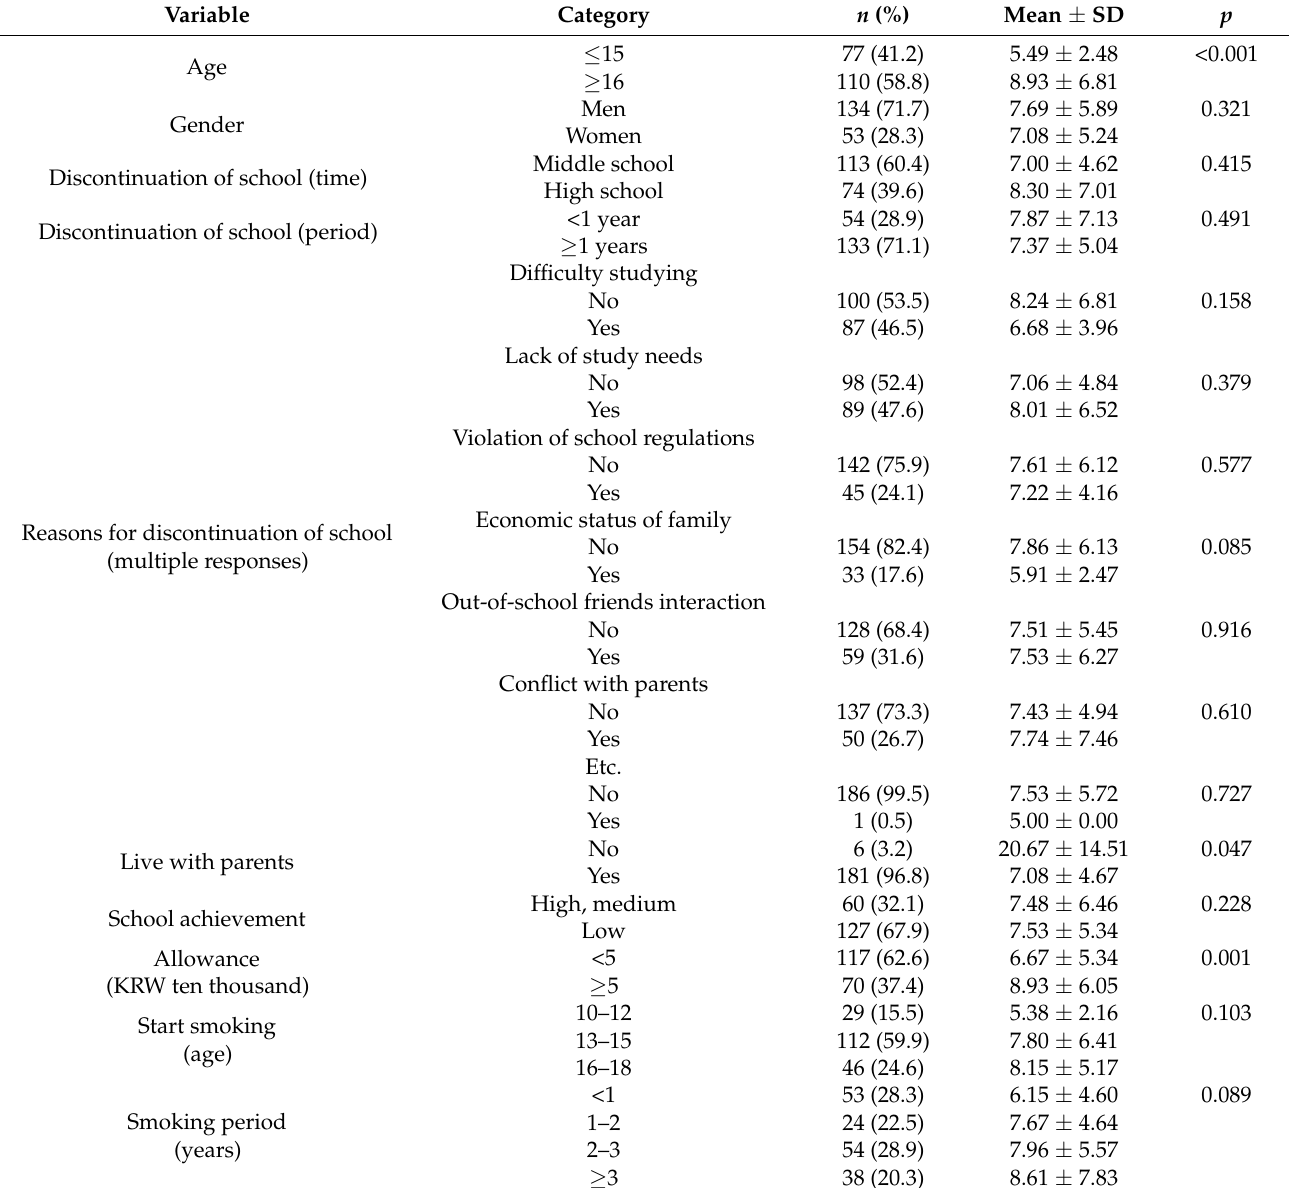
Table 1. Amount of smoking according to the general characteristics of out-of-school adolescents ( N =